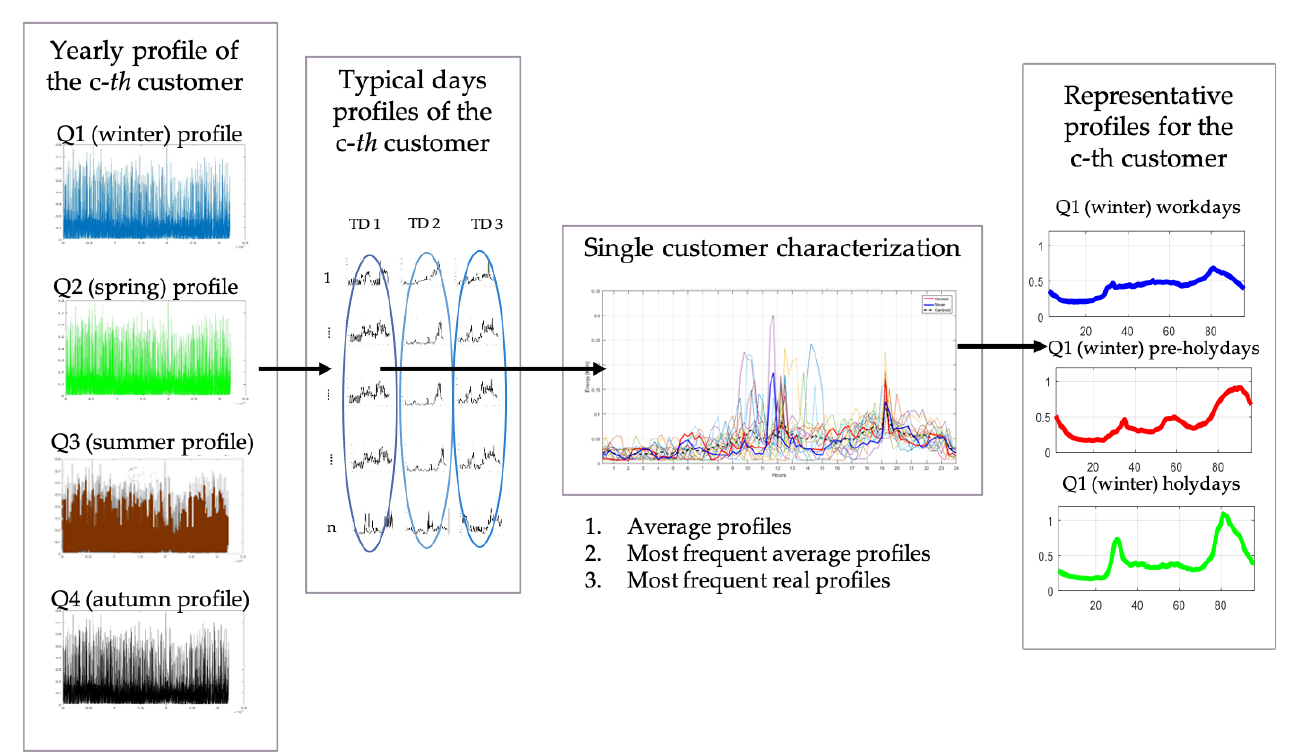
Figure 2. Customer profiling (step 1).